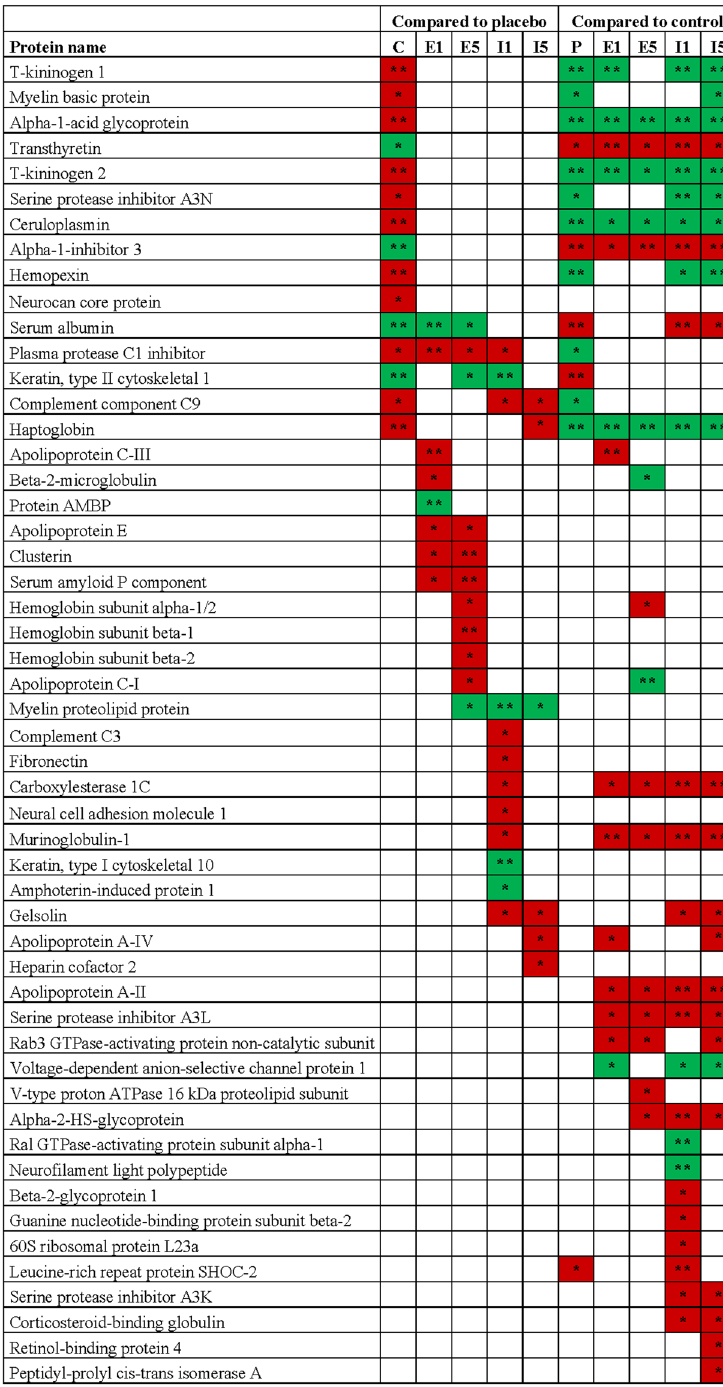
Figure 4. Significant differences in the relative quantification between the treatment groups and the placebo (P) and control (C) groups. Treatments: E1 = etomoxir on day 1; E5 = etomoxir on day 5; I1 = IFN- β on day 1; I5 = IFN- β on day 5. SD under 2.0 on log2 scale. significantly increased or significantly decreased by at least a factor of 2. Number of asterisks indicates level of statistical significance ( * p < 0.05 and ** p < 0.01). More information can be found in Supplementary Figure